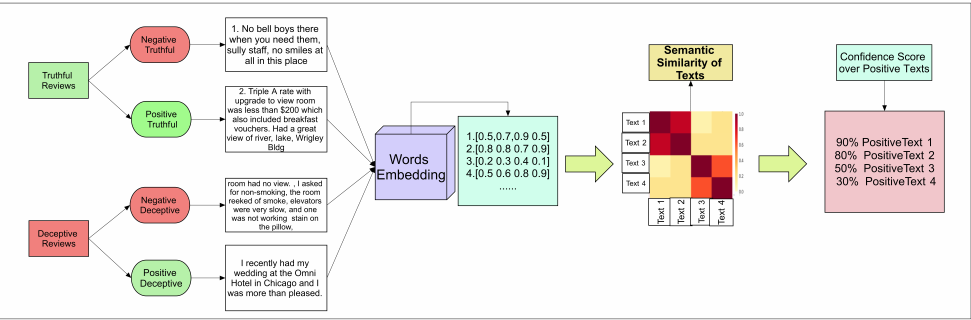
Figure 2. Working Scenerio of USE method in order to calculate similarity